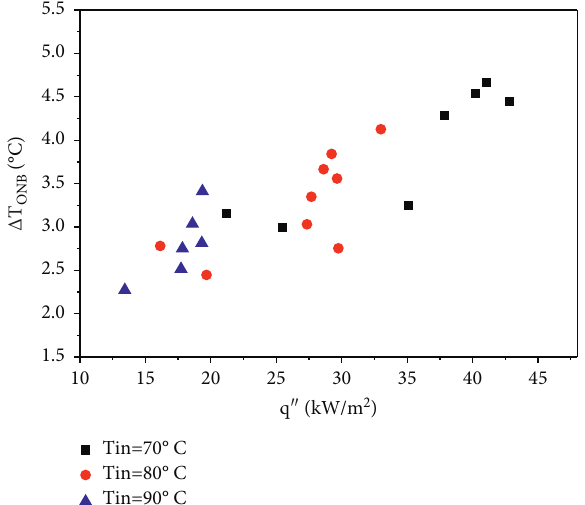
Figure 11: Effect of inlet temperature on Δ T 100kg/(m 2 · s)).